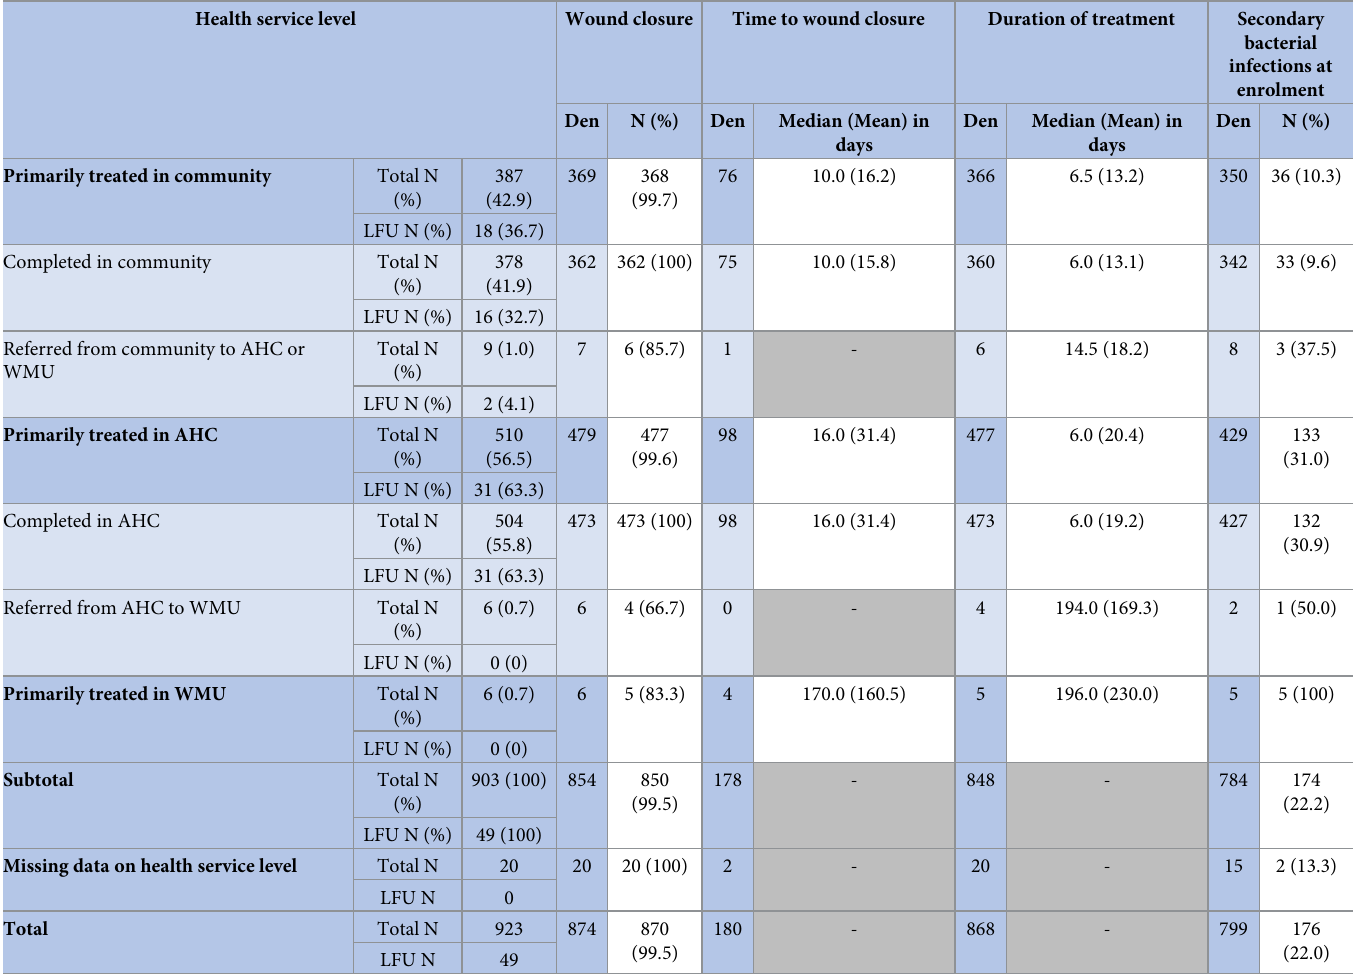
Table 2. Study endpoints for wounds stratified by health service